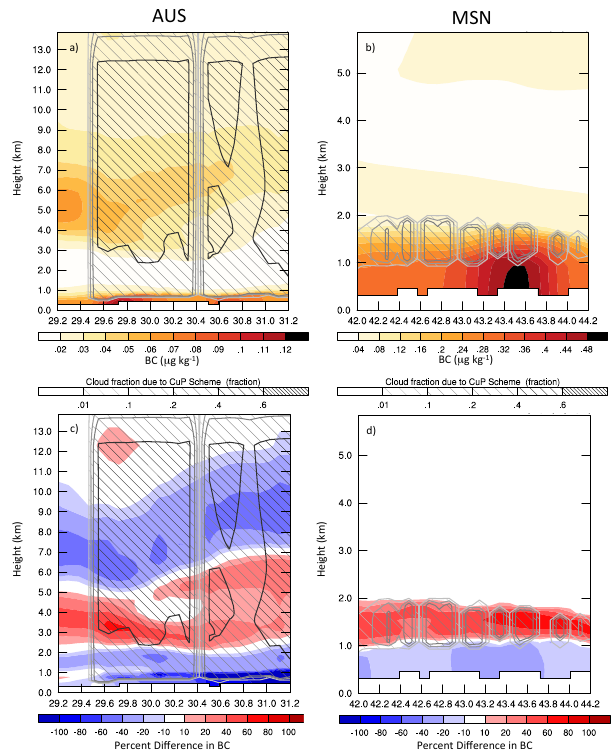
Figure 4. Vertical north–south cross sections of the BC mixing ratio summed over size bins 1 through 4 (color shading in a, b ;µgkg − 1 ), including both interstitial and activated aerosol in the cloudy grid cells, and the difference in the BC mixing ratio between DeepShal- low and Control simulations (color shading in c, d ; percentage) for conditions dominated by deep convective cloud (AUS; a, c ) and shallow convective cloud (MSN; b, d ) boxes at 20:00UTC on 25 June 2007. Hatching indicates the cloud fraction associated with sub-grid convective clouds. The horizontal axes are labeled in de- grees of latitude and the vertical axes are the height above mean sea